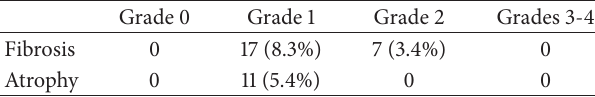
Table 4: Late toxicities according to LENT SOMA scoring scale.